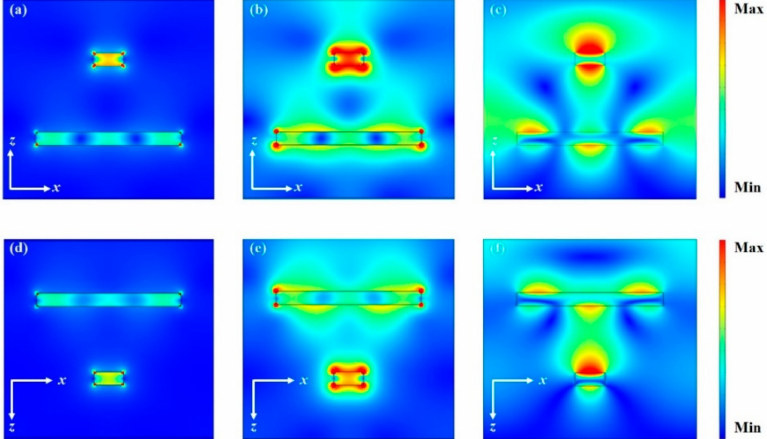
Figure 3. ( a – c ) Current density J, and electric and magnetic field distributions | E | and | H | , respectively, of the structure under forward TM-polarized light incidence. ( d – f ) Current density J, and electric and magnetic field distributions | E | and | H | , respectively, of the structure under backward TM-polarized light